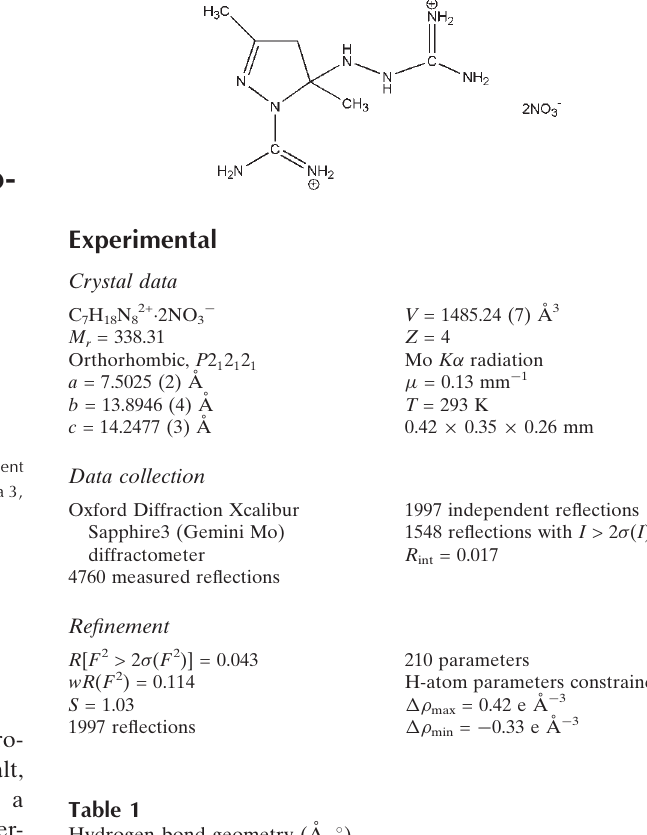
Hydrogen-bond geometry (A˚ , (cid:5)